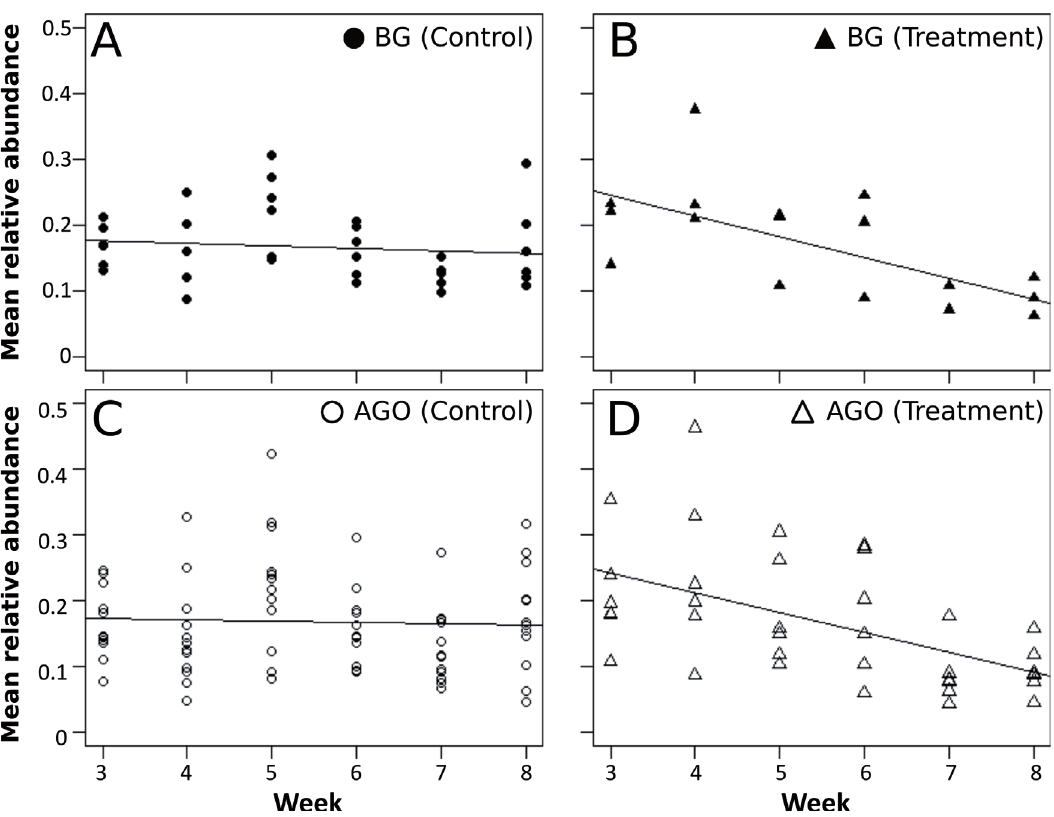
Figure 6. Relative abundance of Ae. aegypti in BGS and AGO-B traps in the control and treatment areas during the 6 week period of AGO-B trap deployment. Relative abundance of females and males were calculated in BGS traps and only females in AGO-B